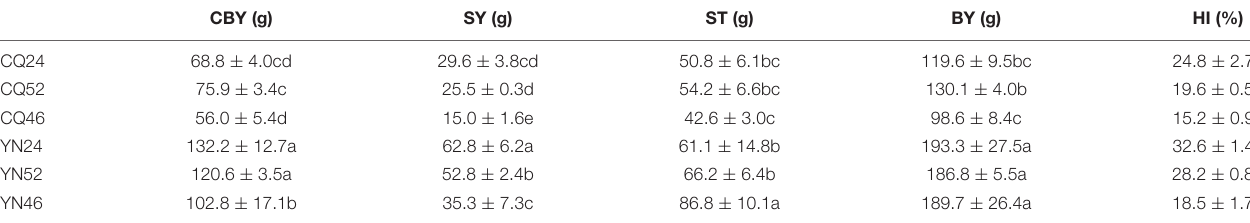
TABLE 1 | Phenotypic values of the three varieties measured in Chongqing and Yunnan. CBY (g) SY (g) ST (g) BY (g) HI